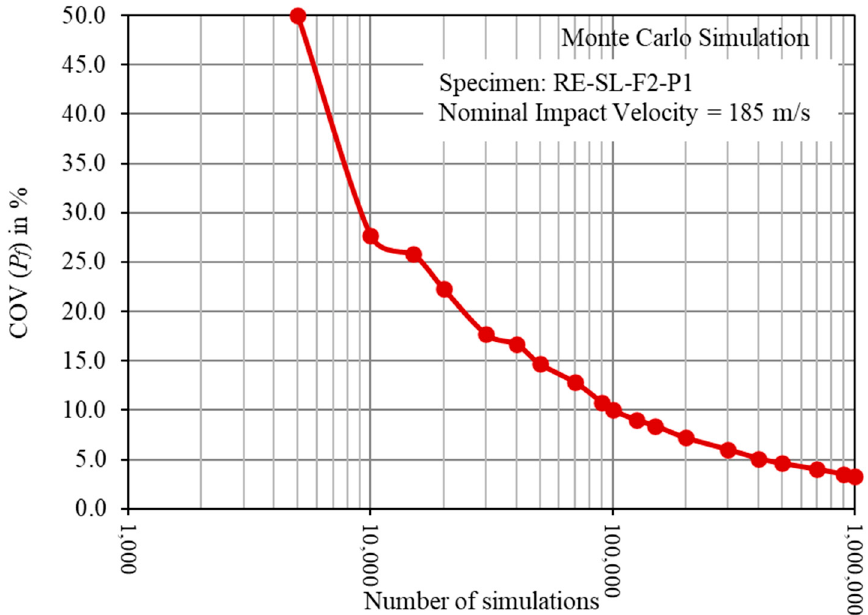
(cid:16) (cid:17) P f with the number of